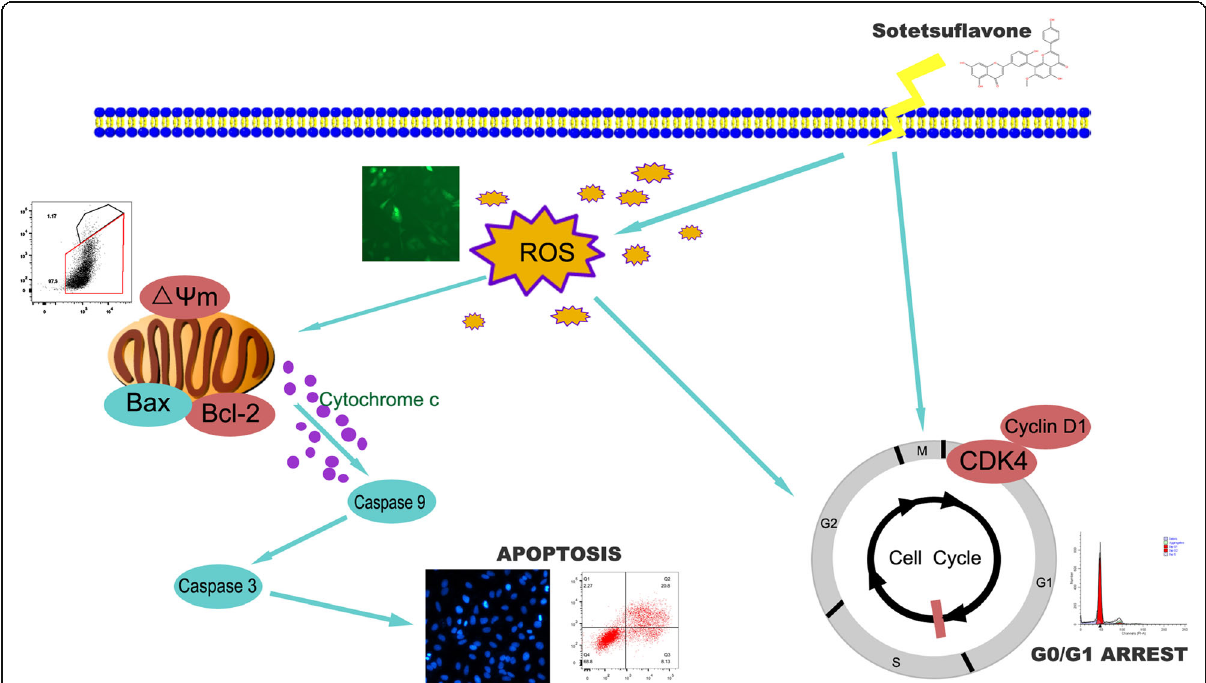
Fig. 7 Hypothetical mechanism of sotetsuflavone induced apoptosis of A549